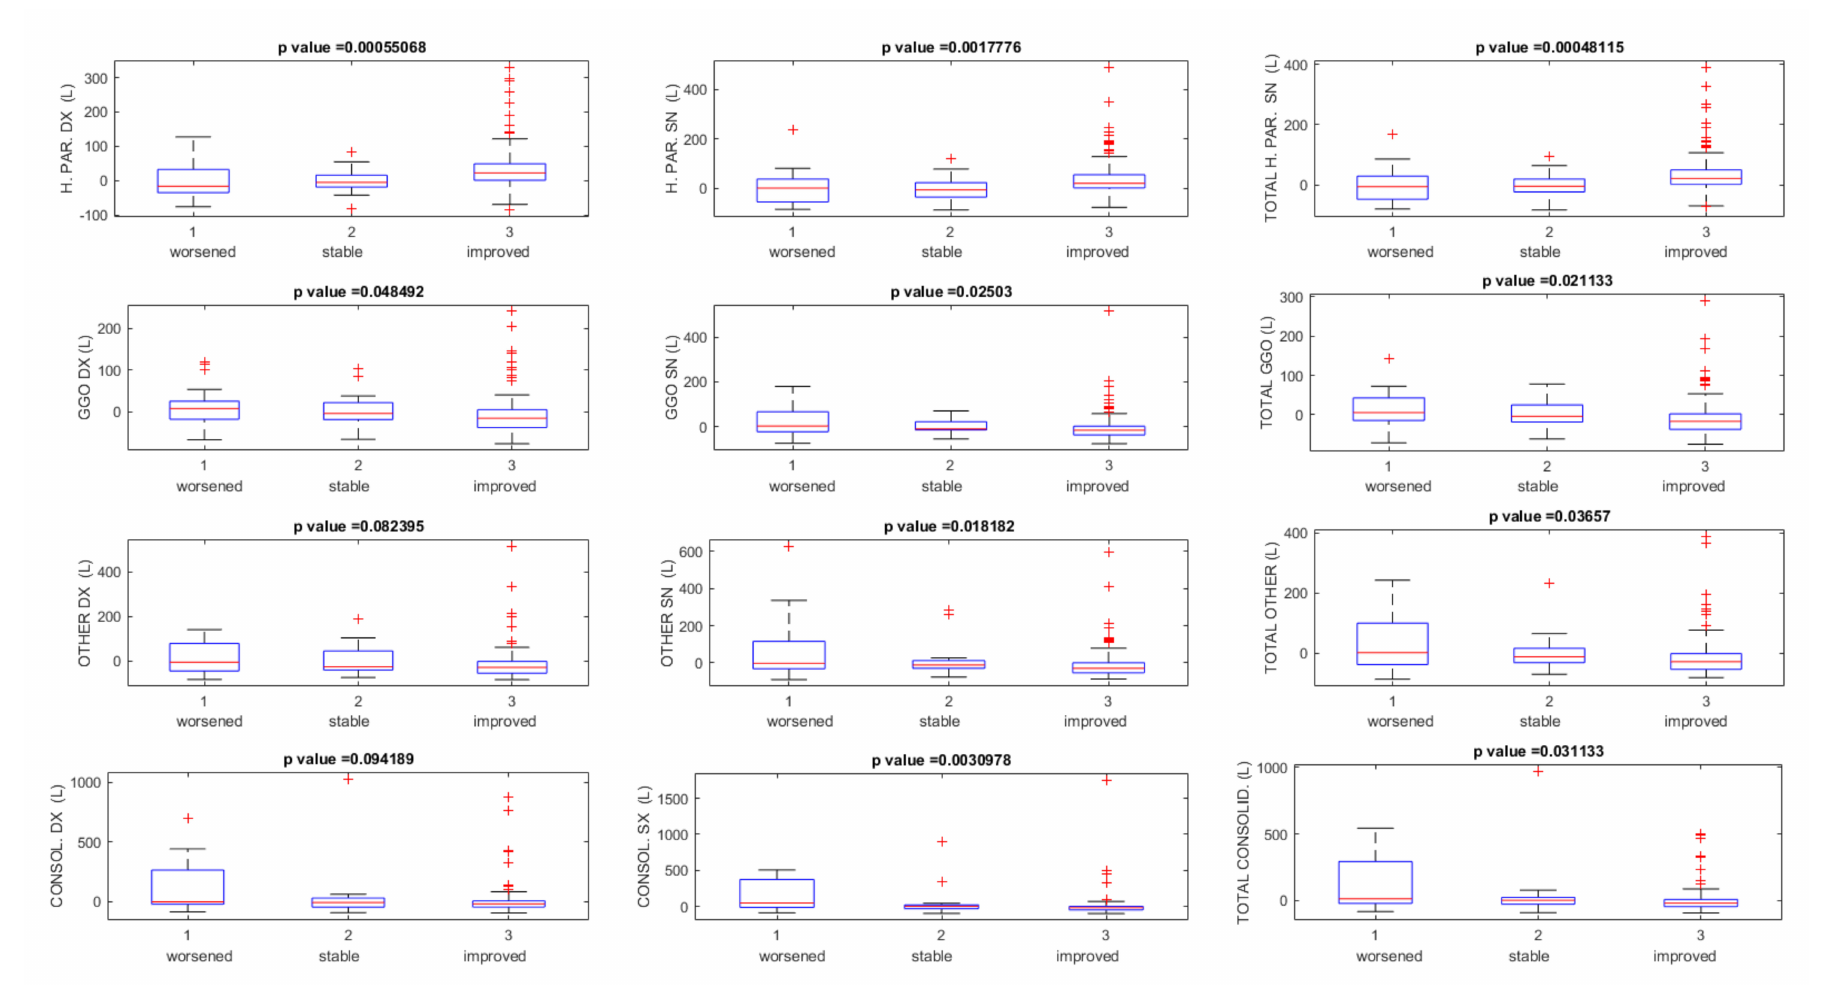
Figure 1. Boxplots of quantified volumes on CT using the computer tool based on the clinical condition (stable, improved, and worsened). Note: H. PAR. = healthy parenchyma, GGO = ground glass opacity; CONSOL = consolidation; R = right; L =